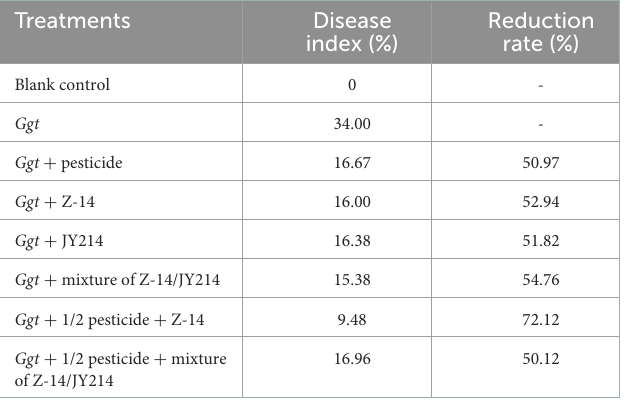
TABLE 5 Control effect of pesticide, Z-14, JY214, and their combinations on wheat take-all disease in the field experiments. Treatments Disease index (%)